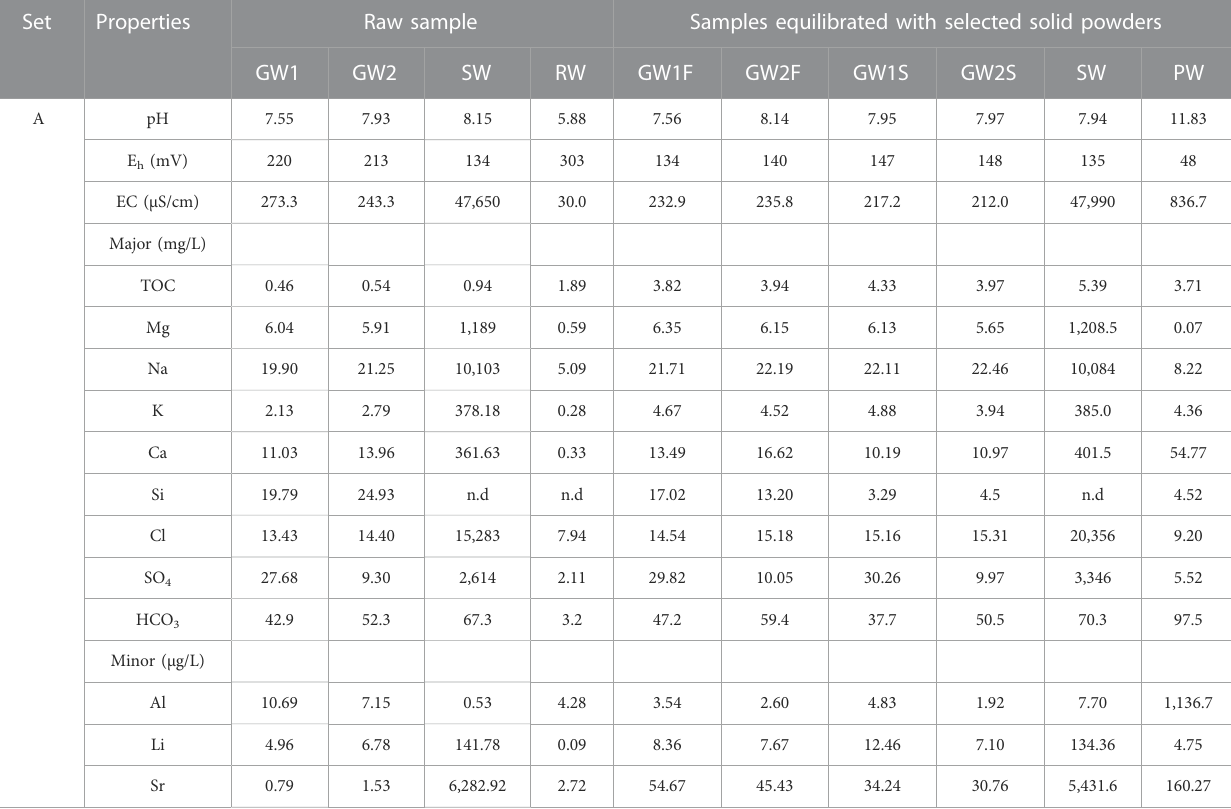
TABLE 2 Physical and chemical properties of representative natural water samples before and after equilibrated with the selected solid phase. Set